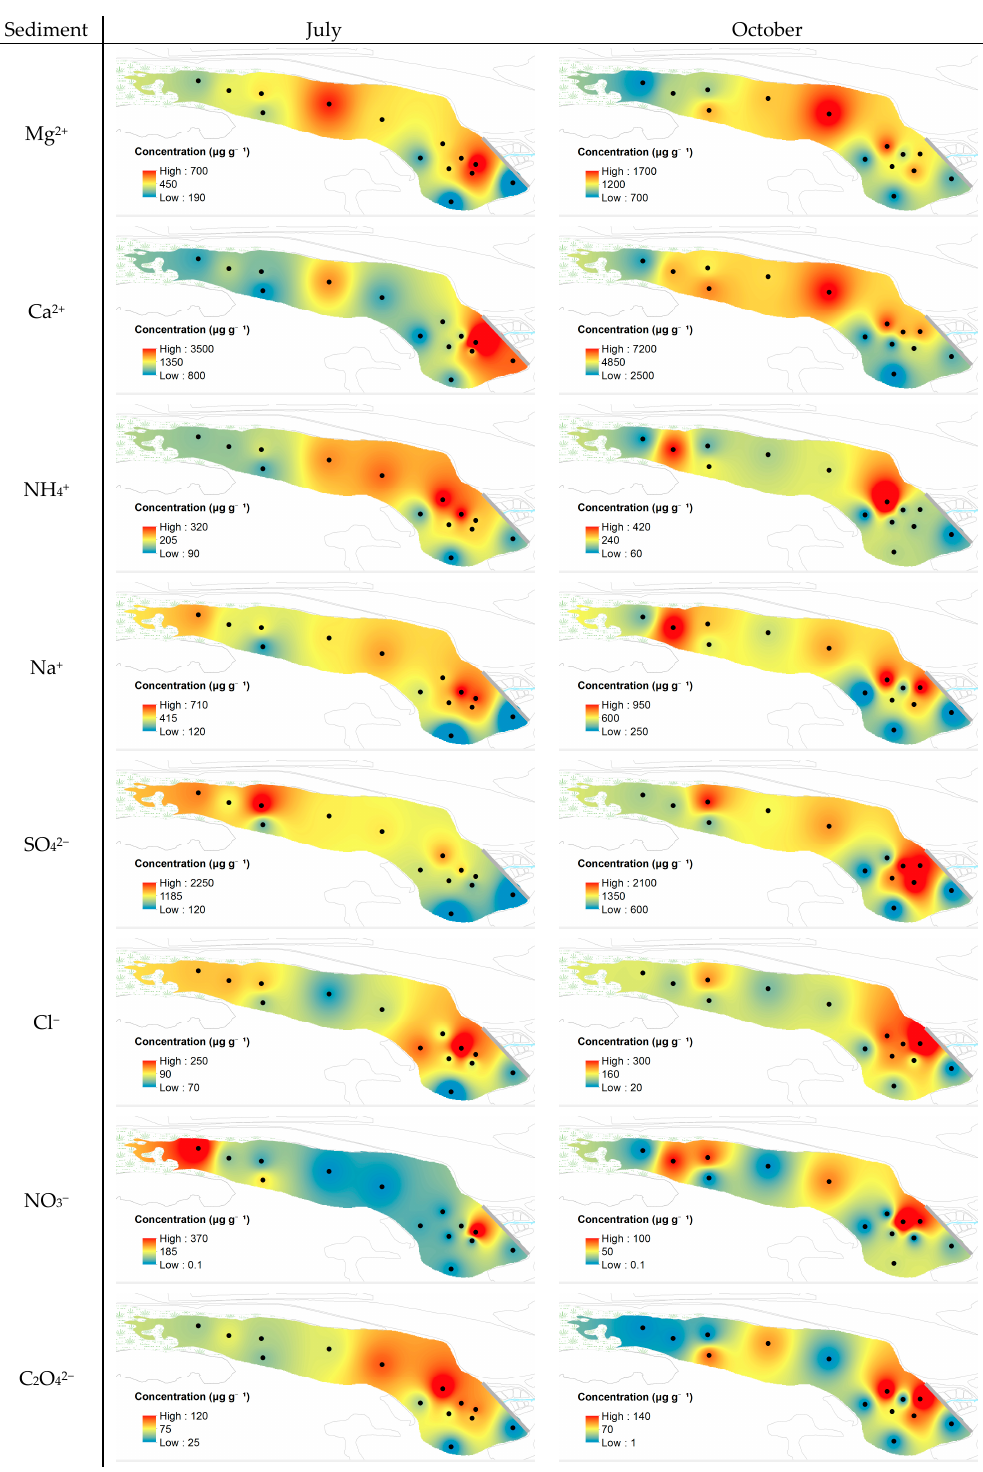
Figure 7. Spatial distribution of Mg 2+ , Ca 2+ , NH 4+ , Na + , SO 42 − , Cl − , NO 3 − , and C 2 O 42 − in sediment of Podu Iloaiei Dam Lake for July and October sampling sessions.